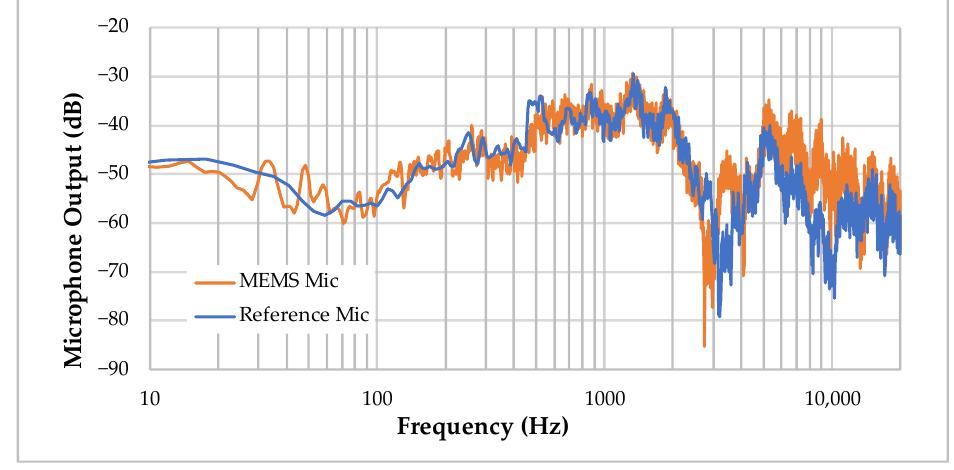
Figure 15. Frequency response comparison of the logger MEMS microphone with a reference microphone.